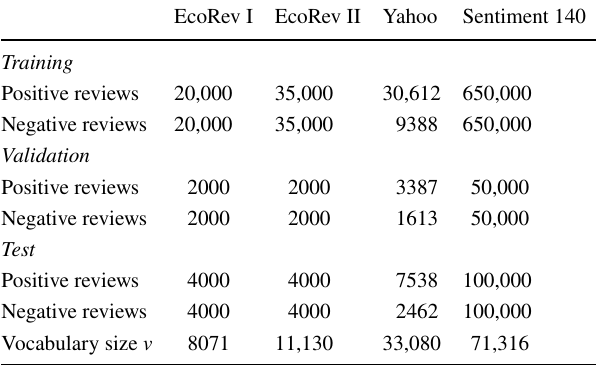
Table 1 Dataset organization for text